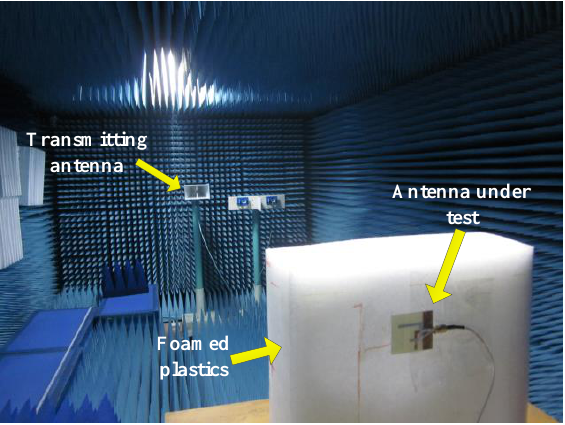
Figure 12. Calculated and experimental S 11 of the proposed NTTPA.